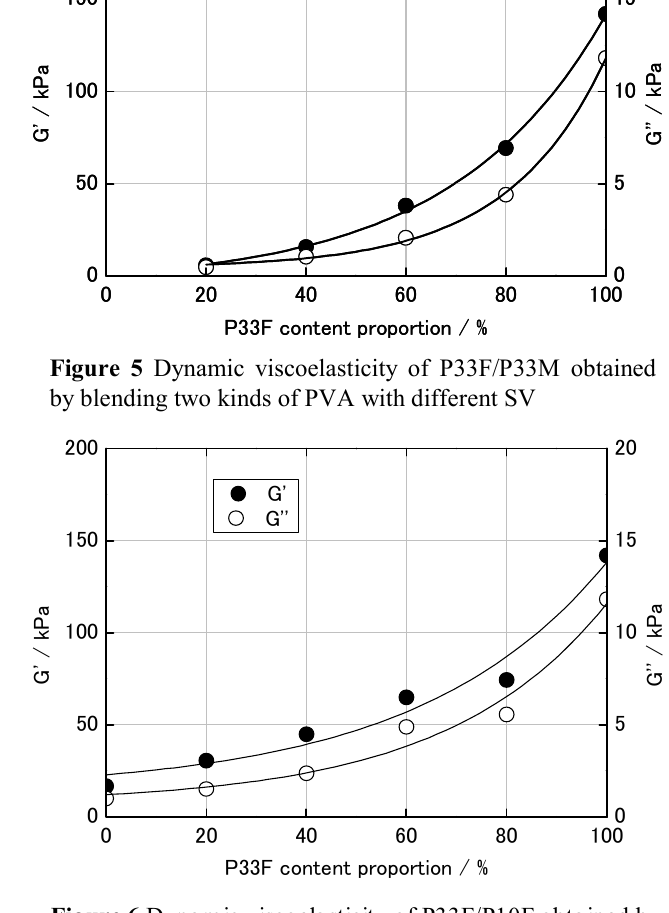
Figure 6 Dynamic viscoelasticity of P33F/P10F obtained by blending two kinds of PVA with different